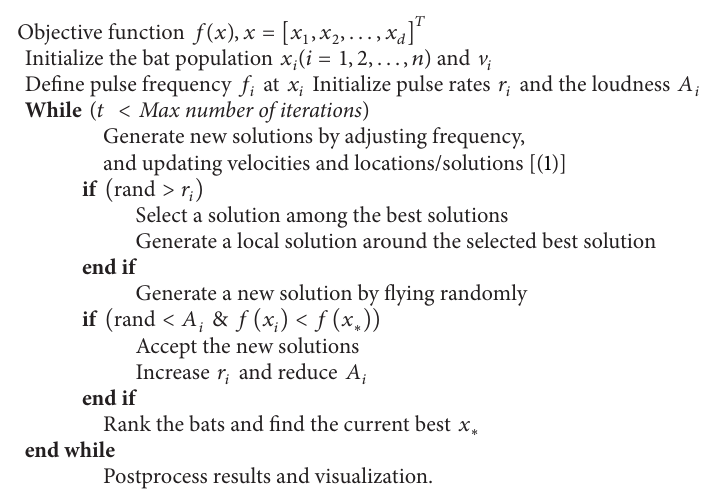
Algorithm 1: Pseudocode of the bat algorithm (BA)